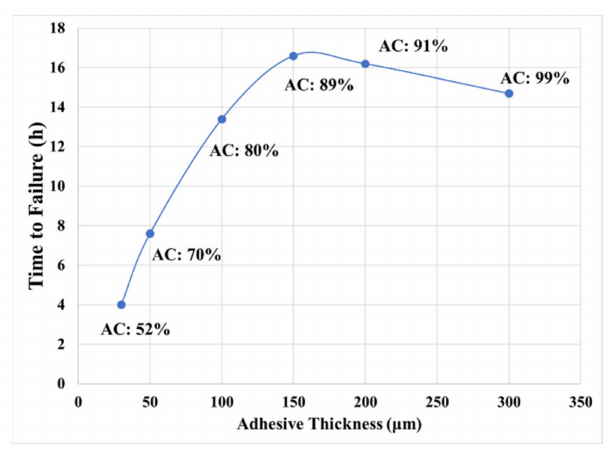
Figure 20. Effect of thickness on creep resistance (AC is the percentage of actual contact area defined by the bonding area divided by the substrate nominal